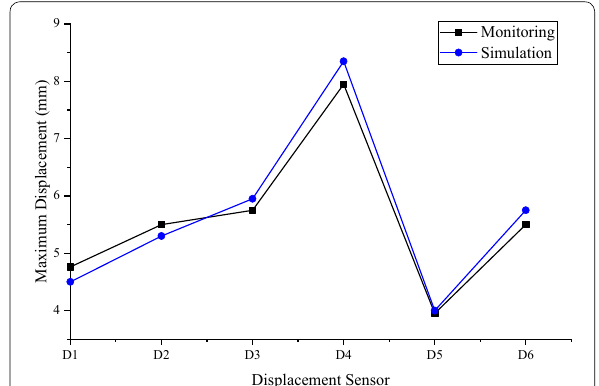
Fig. 11 Comparison of the maximum barricade displacement between the model prediction and in situ measurement corresponding to different monitoring sensors.